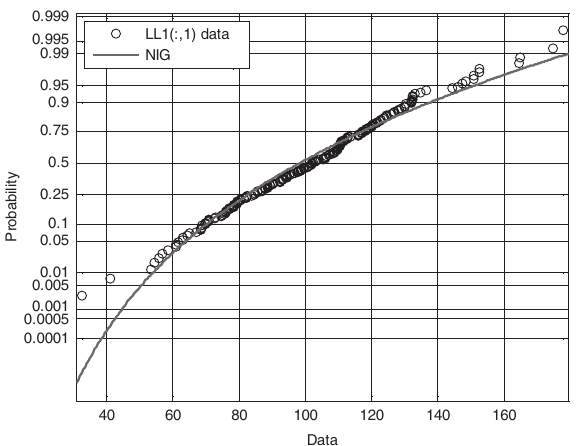
Figure 4: Probability Plot for LL Sub-band.